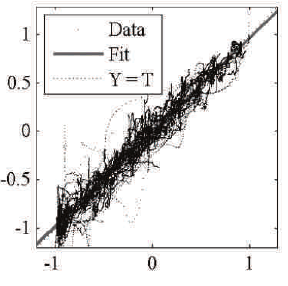
Fig. 6. ANN data fit after training process